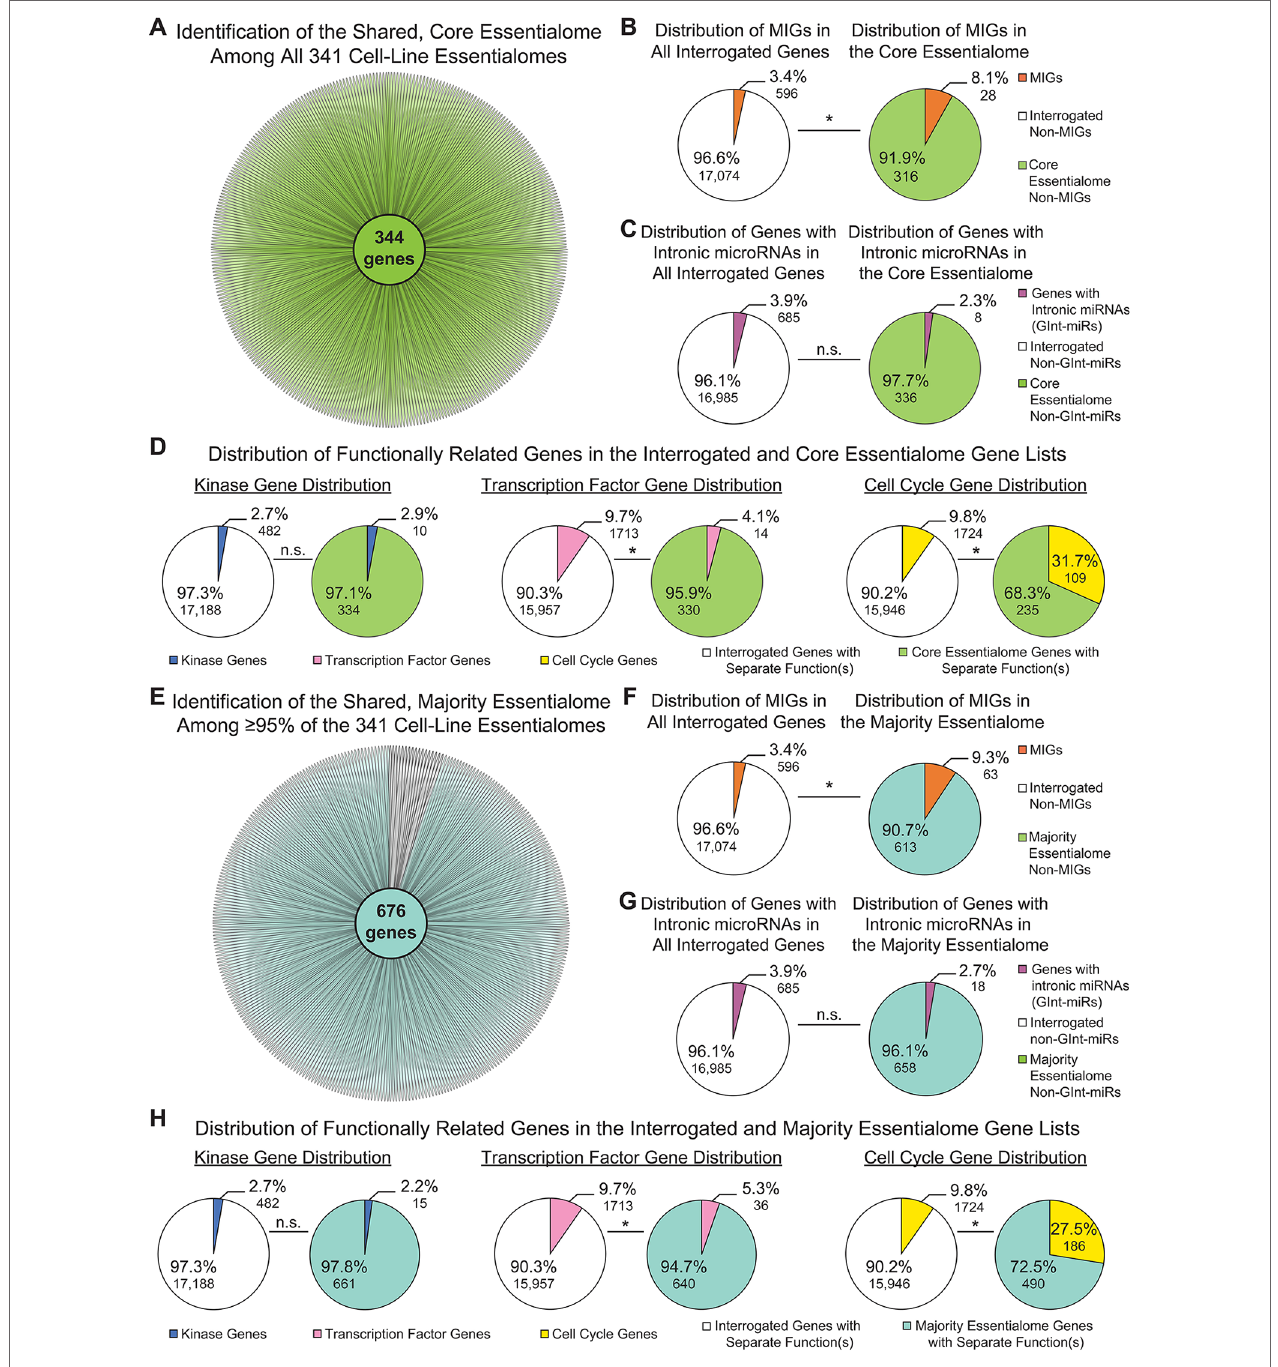
FIGUrE 3 | Minor intron-containing genes (MIGs) are enriched in shared essential genes. (A) Daisy model showing the number of essential genes common to all 341 cell-line essentialomes (“core essentialome”; green circle). Each petal corresponds to one cell-line essentialome. (B) Pie charts showing the percentage of MIGs in all interrogated genes (left) and in the core essentialome (right). (C ) Pie charts showing the percentage of genes with intronic microRNA genes (GInt-miRs) in all interrogated genes (left) and in the core essentialome (right). (d ) Pie charts showing the percentage of genes with kinase activity (leftmost), transcription factor activity (middle), or a role in cell cycle regulation (rightmost) in all interrogated genes and in the core essentialome. (E) Daisy model showing the number of essential genes common to the majority (≥95%) of the 341 cell-line essentialomes (“majority essentialome”; teal circle). (F) Pie charts showing the percentage of MIGs in all interrogated genes (left) and in the majority essentialome (right). (G) Pie charts showing the percentage of genes with intronic microRNA genes (GInt-miRs) in all interrogated genes (left) and the majority essentialome (right). (H) Pie charts showing the percentage of genes with kinase activity (leftmost), transcription factor activity (middle), or a role in cell cycle regulation (rightmost) in all interrogated genes and in the majority essentialome. Statistical significance was determined by Fisher’s exact test. N.s., not significant, * P ≤ 1.40E−04.